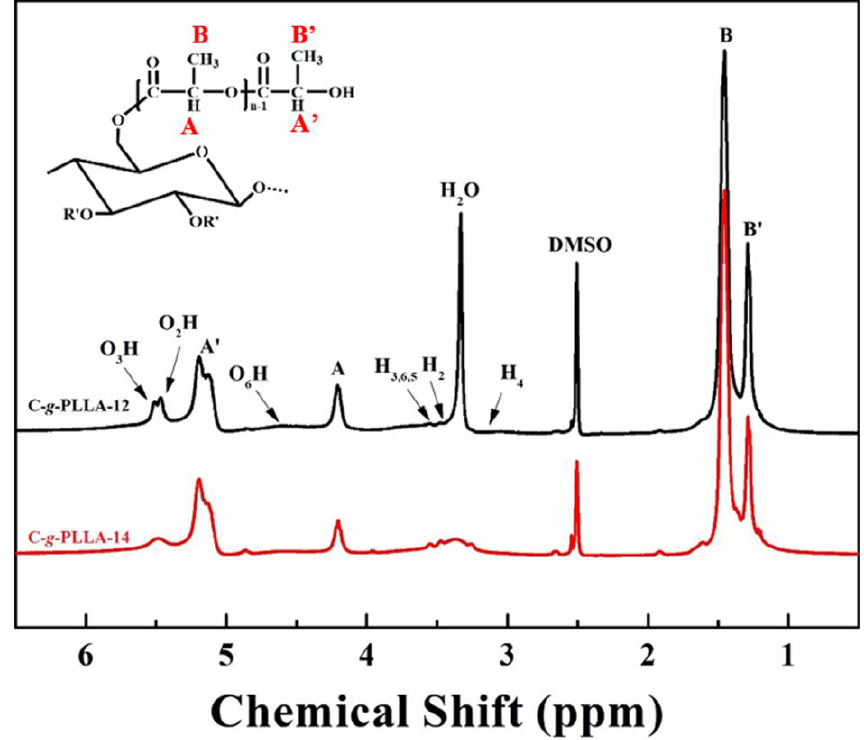
Figure 1. 1 H NMR spectra of C- g -PLLA.